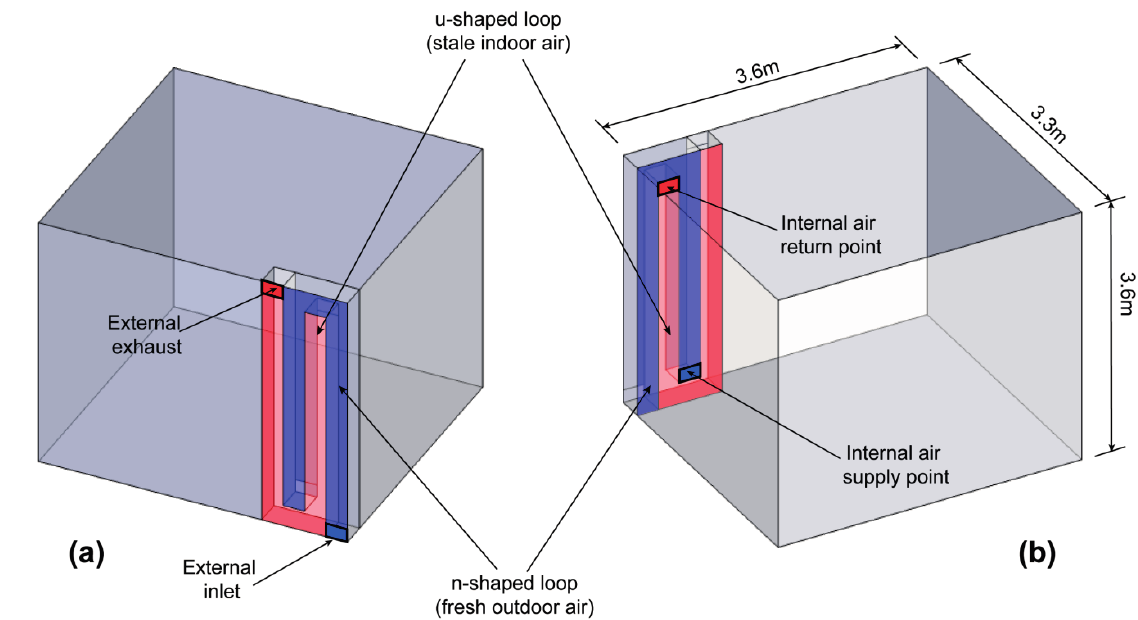
Figure 3. The position of simulated LoH Chamber from ( a ) external view; and ( b ) internal